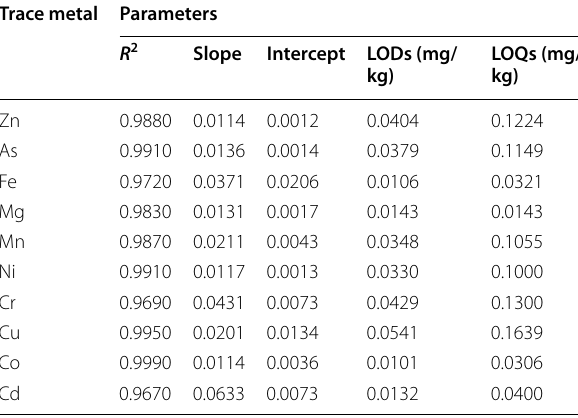
Table 2 Characteristics performance of ICP-OES calibration